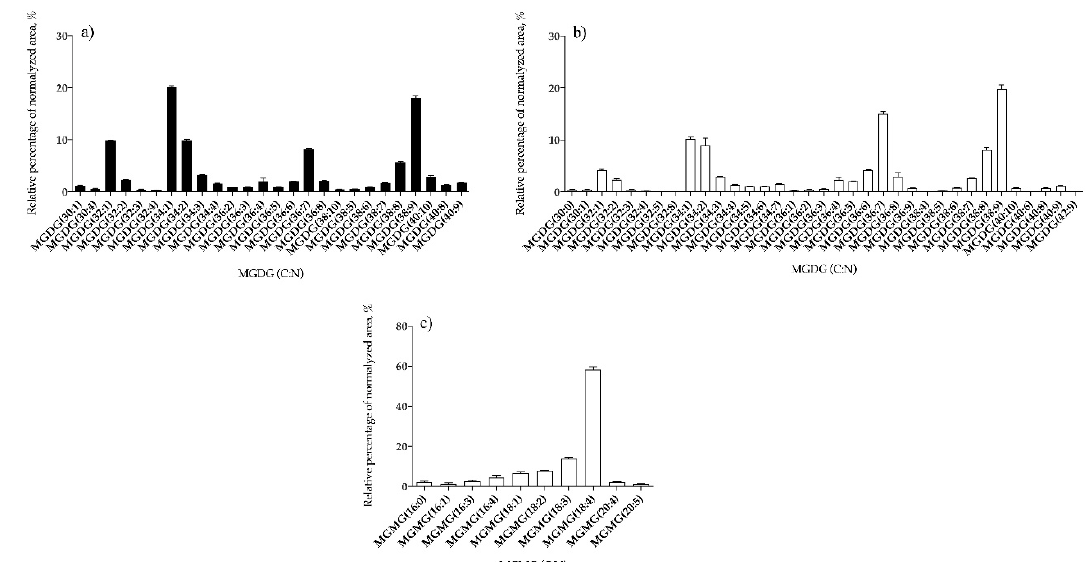
Figure 2. Relative abundances (RA) of lipid species of monogalactosyl diacylglycerol (MGDG) identified in B. bifurcata (a) and S. muticum (b) and of monogalactosyl monoacylglycerol (MGMG) identified in S. muticum (c). The results are expressed as relative percentage after dividing the normalized peak area of each lipid species to the sum of normalized peak areas for all the lipid species within the class obtained after LC–MS analysis. Numbers in parentheses (C:N) indicate the number of carbon atoms (C) and double bounds (N) in the fatty acid side chains. The species with higher RA were MGDG (34:1) for B. bifurcata and MGDG (38:9) and MGMG (18:4) for S. muticum .